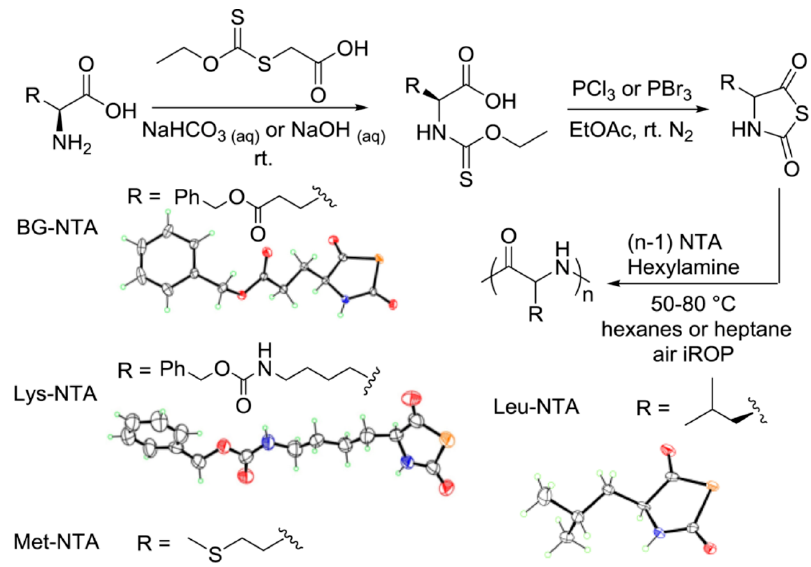
Figure 16. Synthetic Route towards N -thiocarboxyanhydrides (NTAs) according to Cao et al. [82].